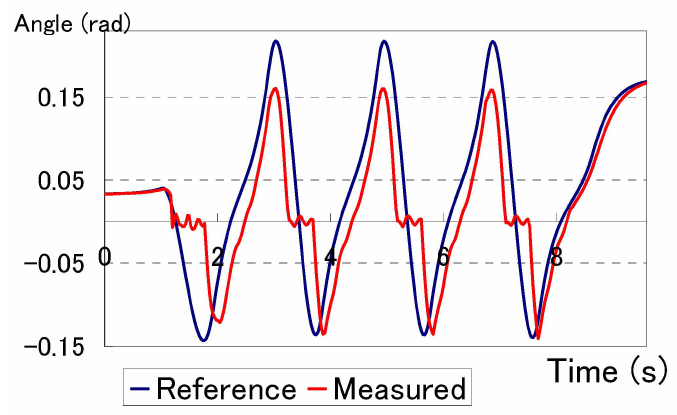
Figure 4. Position of the right ankle pitch joint for hybrid walking